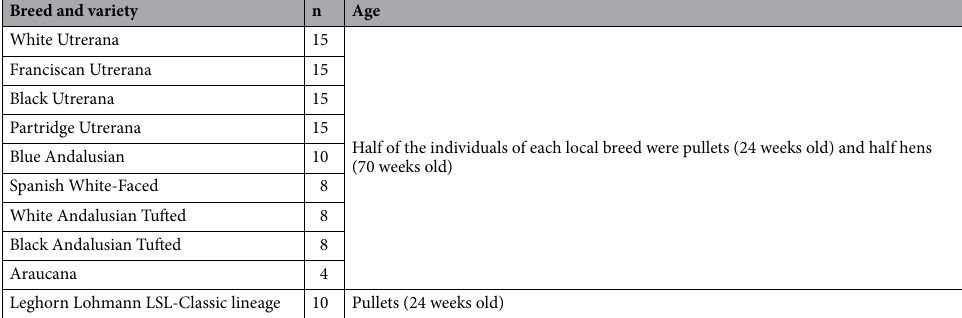
Table 4. Number of individuals (N) used in each studied breed and